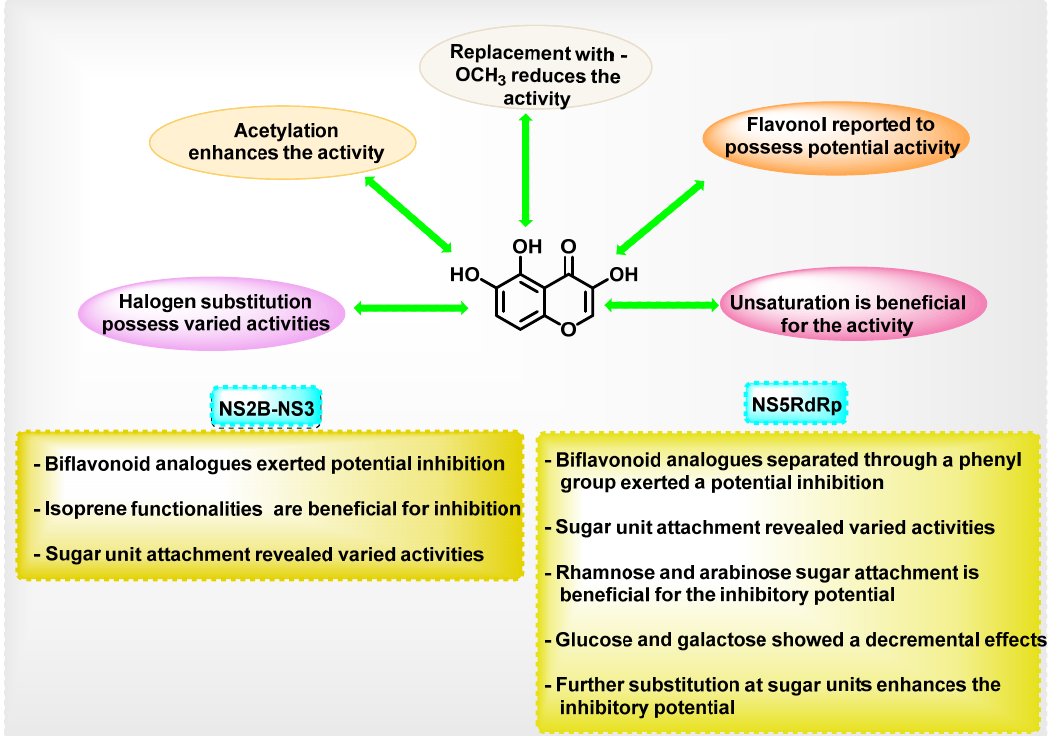
Figure 21. Summary of SAR points in dengue inhibition.